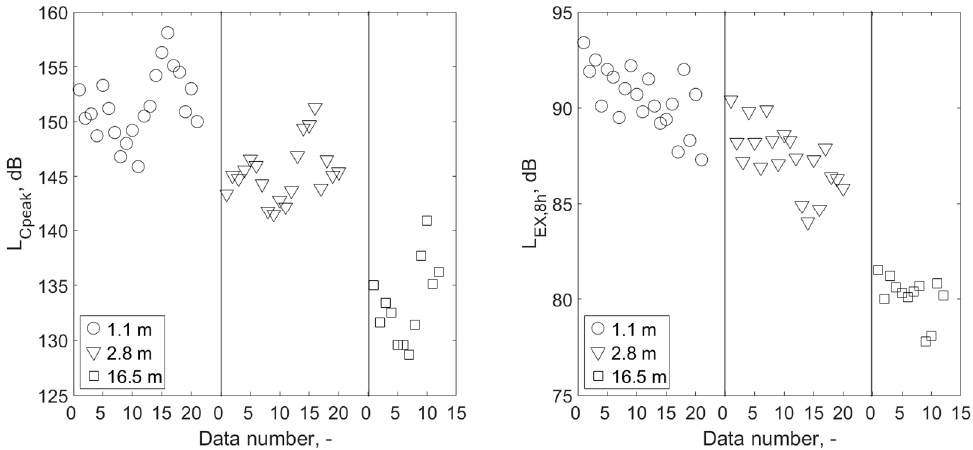
Figure 7. Values of L Cpeak and L EX,8h parameters measured at the shooting instructor’s locations, divided into three variants of the instructor’s distance from the shooters, covering all the types of weapon/ammunition combinations included in the training plan on the shooting